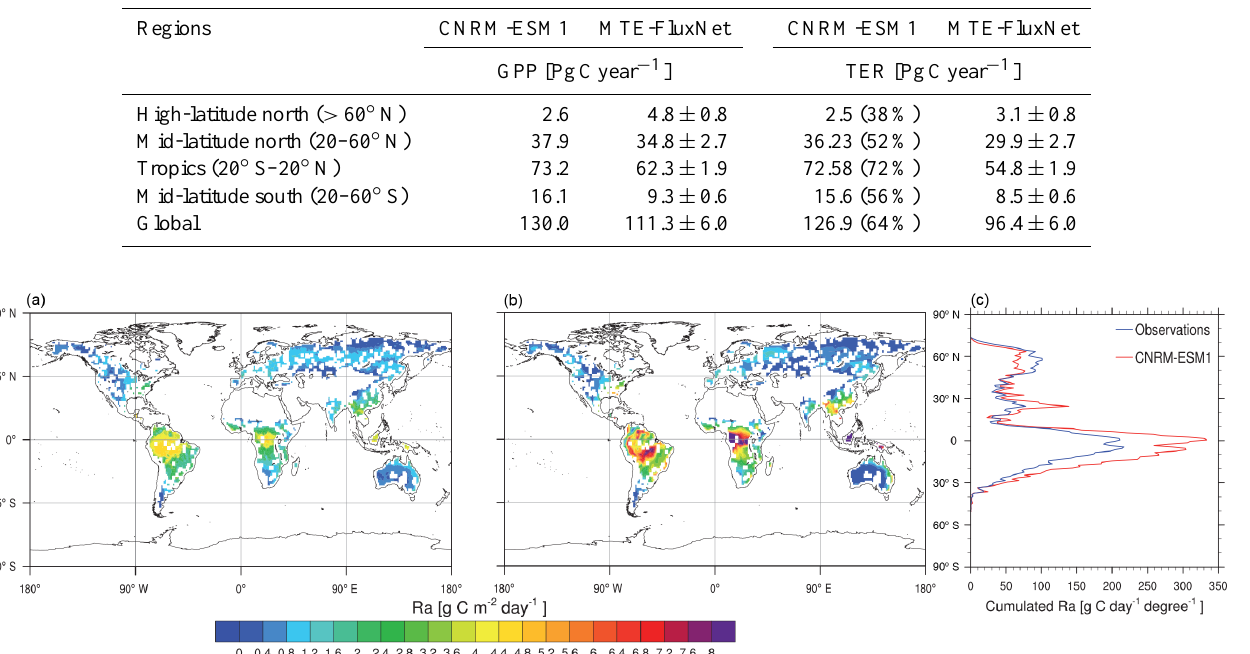
Figure 12. Annual-mean autotrophic respiration (Ra) as estimated from MODIS over 2000–2013 (a) and as simulated by CNRM-ESM1 (b) over 1986–2005. Panel (c) represents the zonal-cumulated Ra in function of latitude for both satellite-derived estimates (in blue) and CNRM-ESM1 (in